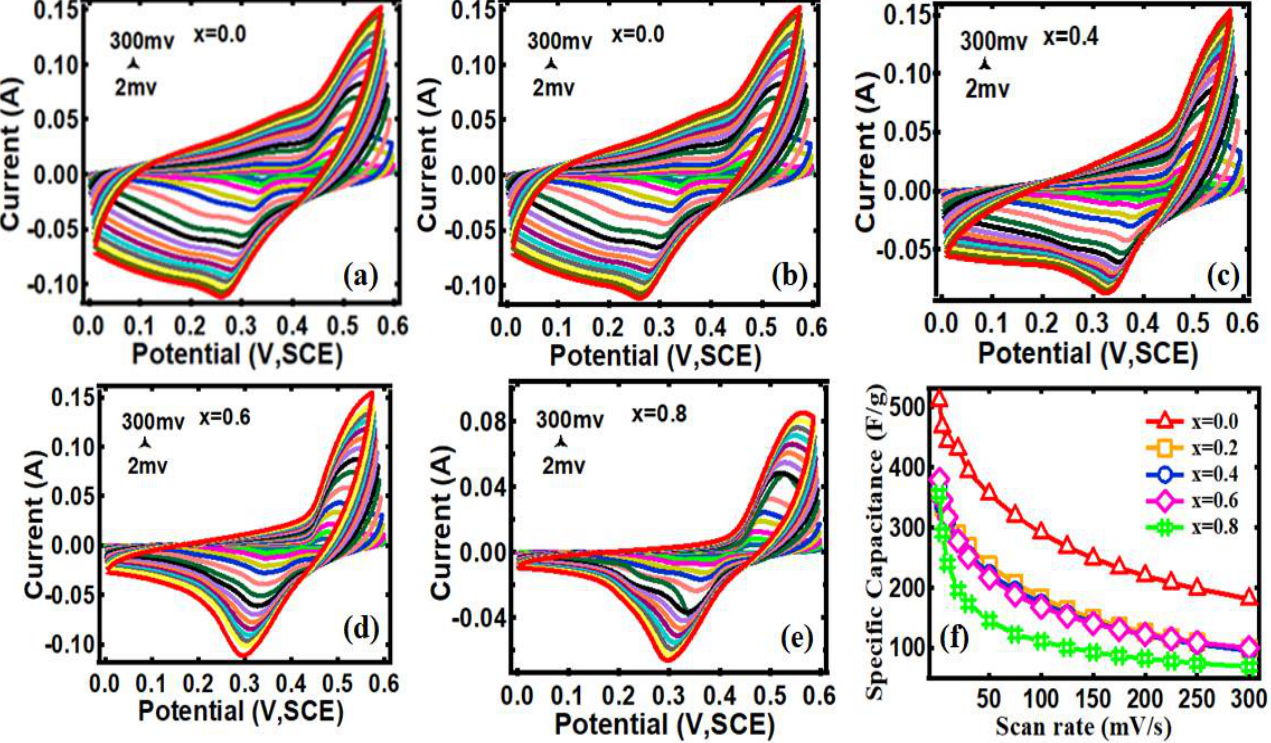
Figure 4. ( a - e ) are cyclic voltammetry curves of Ni 1-x Al x Co 2 O 4 , electrode obtained in the scan range of 5 mV/s to 300 mV/s Figure 4. ( a – e ) are cyclic voltammetry curves of Ni 1 − x Al x Co 2 O 4 , electrode obtained in the scan range of 5 mV/s to 300 mV/s measured in 3M KOH electrolytes. Figure ( f ) specific capacitance vs. scan rate. measured in 3M KOH electrolytes. Figure ( f ) specific capacitance vs. scan